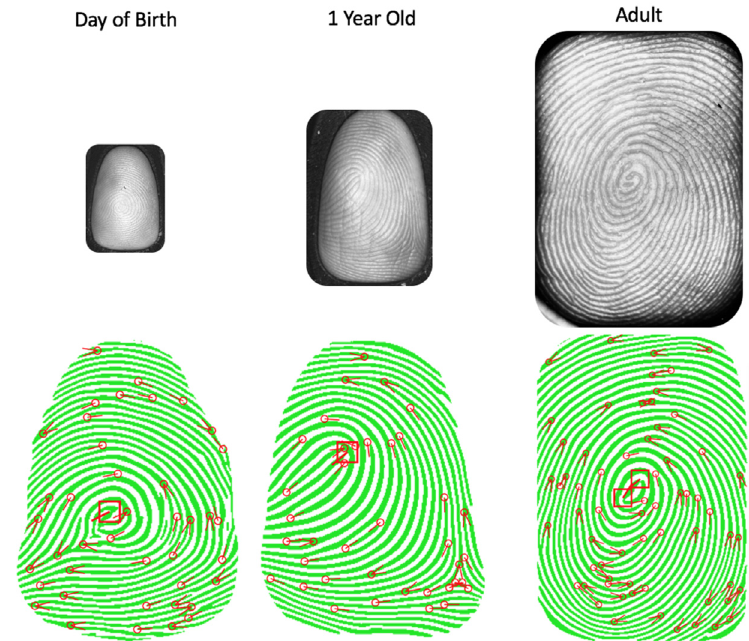
Figure 18. Newborn, 1-year old, and adult images (top) with processed templates and minutiae (bottom).